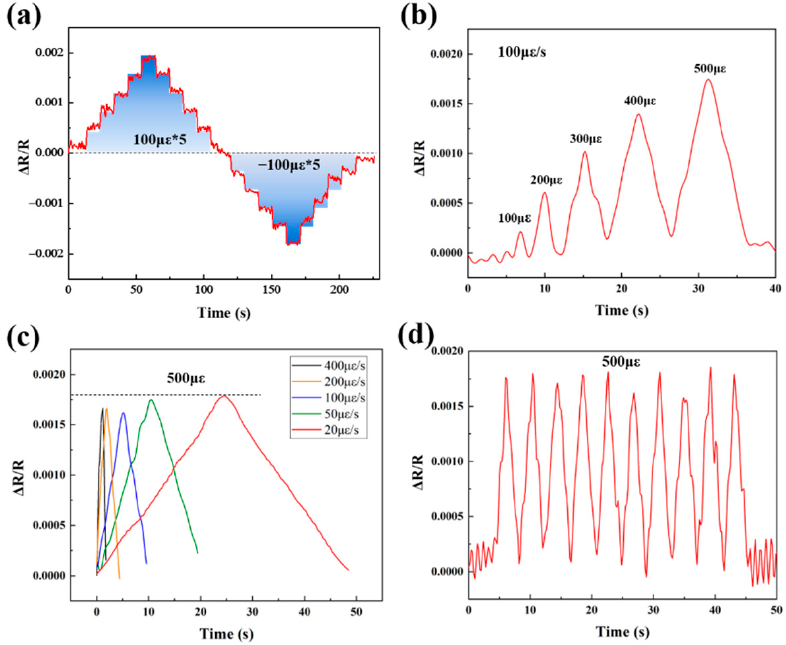
Figure 5. Piezoresistive response of the ZrB 2 (50 wt%)/SiCN TFSG: ( a ) The static response; ( b ) The response of different strain quantities at a constant strain rate (100 µε /s); ( c ) The response at different strain rates; ( d ) The cyclic response.